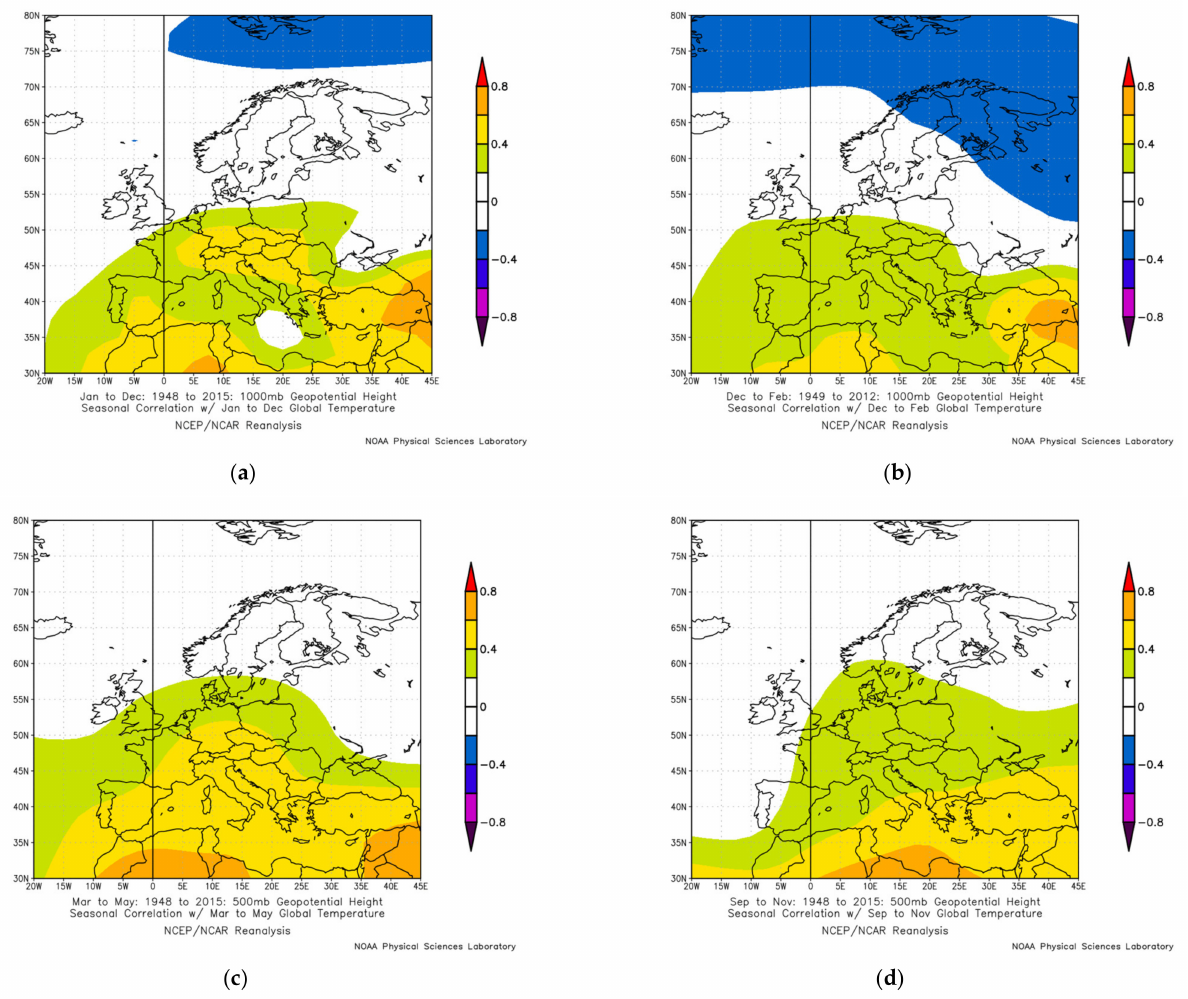
Figure 6. Correlations of the 1000 hPa geopotential height with global temperature for the ( a ) annual series, ( b ) winter series, ( c ) spring series, and ( d ) autumn series. Correlation coefficients r < − 0.2 and r > +0.2 are significant at the 90% confidence